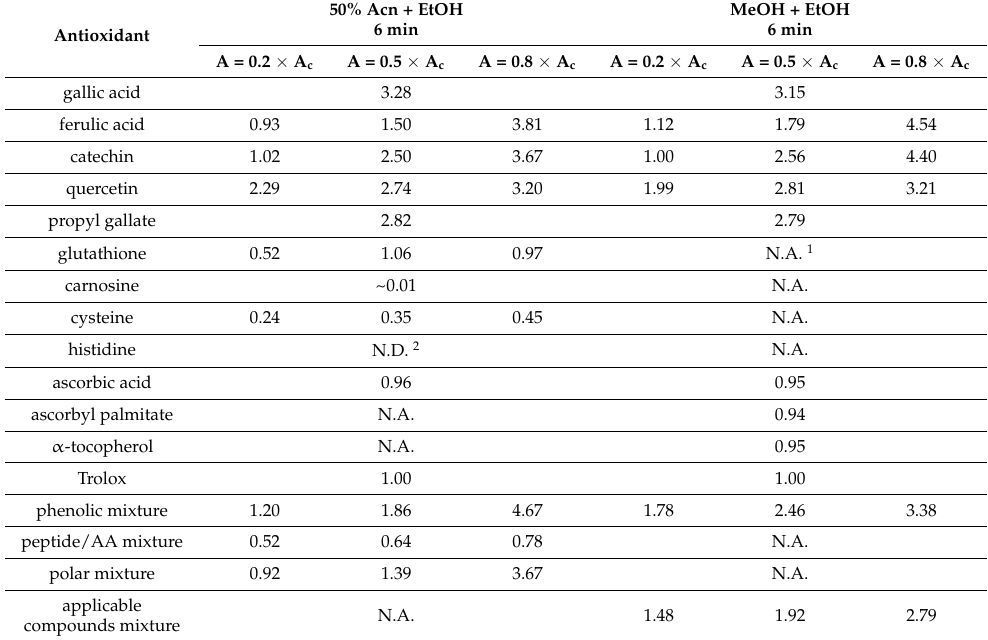
Table 9. TEAC values determined against ABTS radical cations applied in 50% acetone or methanol (radical solution diluted with ethanol) after standard reaction time.